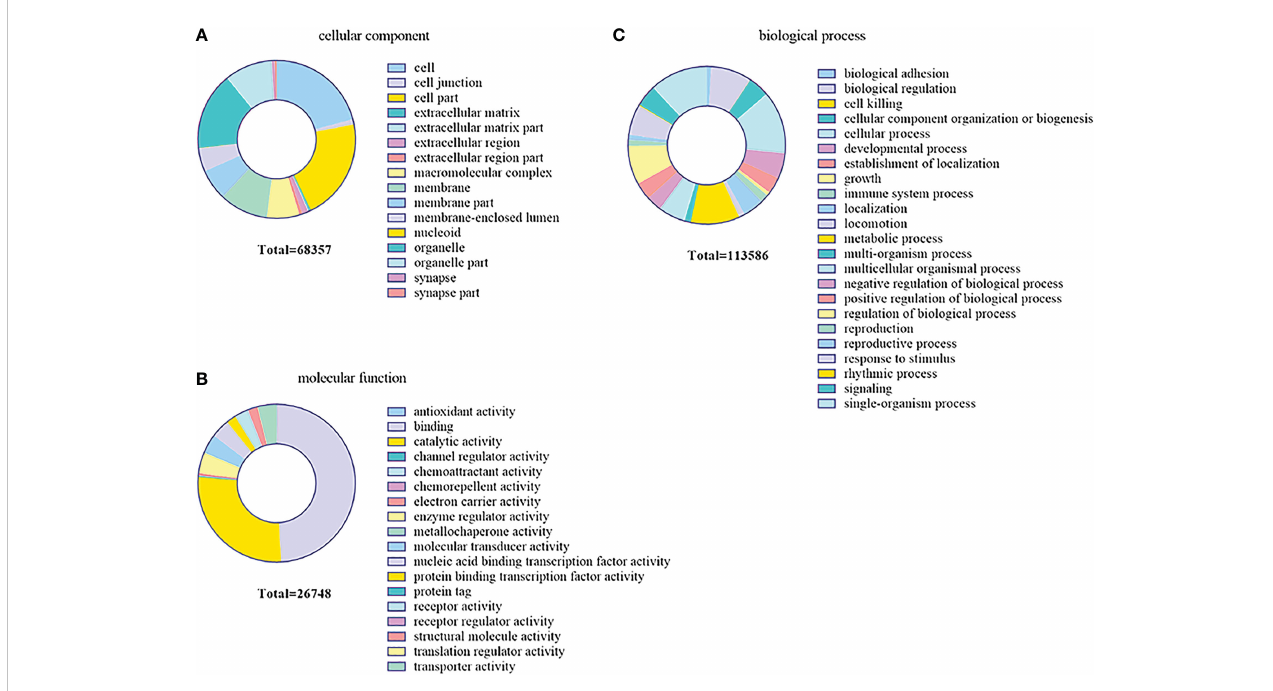
FIGURE 7 Gene Ontology (GO) enrichment analysis of the target genes predicted for the differentially expressed miRNAs (DEMs) in the gills. (A) Cellular component. (B) Biological process. (C) Molecular